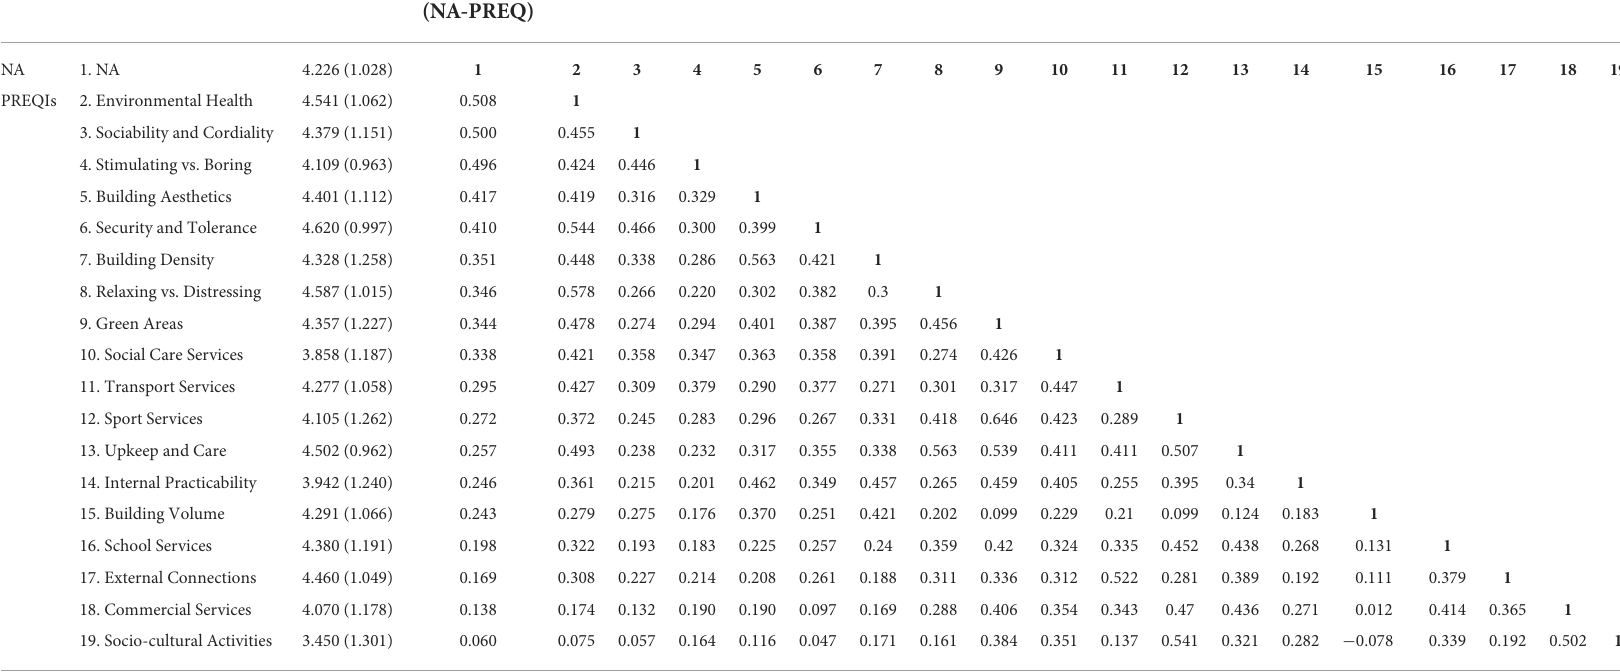
TABLE 5 PREQ and NA indicators: mean, standard deviation, and correlational matrix ( N = 1,332). Variable Mean (SD)